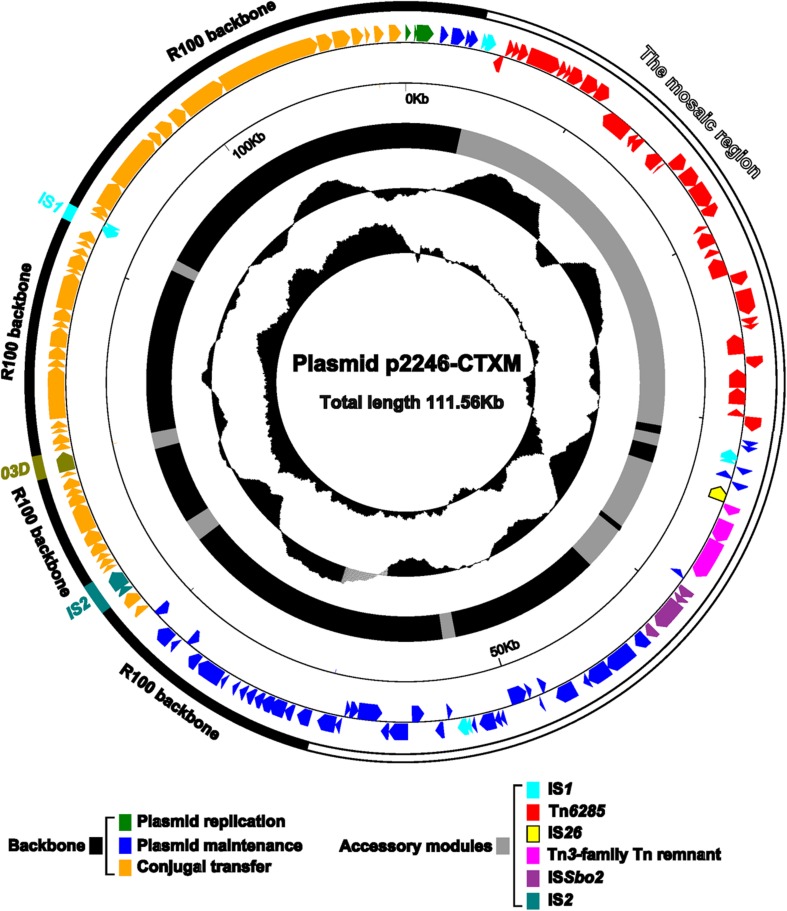
Schematic map of p2246-CTXM. Genes are denoted by arrows and colored based on gene function classification. The innermost two circles present the GC-Skew [(G-C)/(G+C)] and the GC contents. Shown also are the backbone and the accessory modules, respectively.